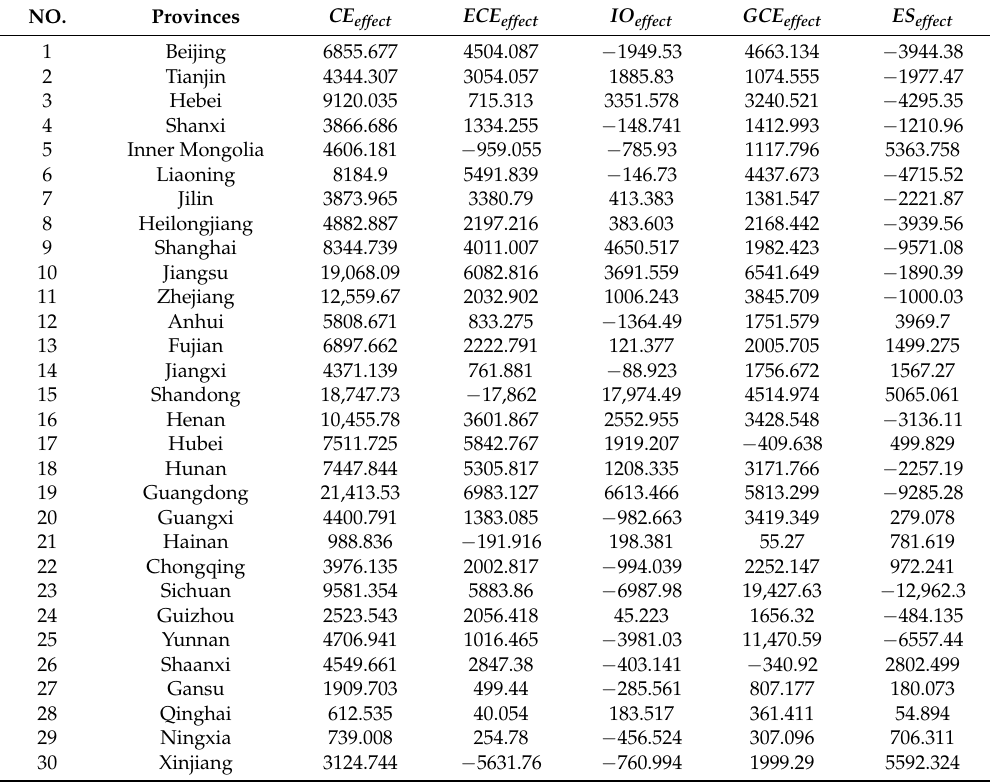
Table A4. Second-stage absolute decomposition results for each province.